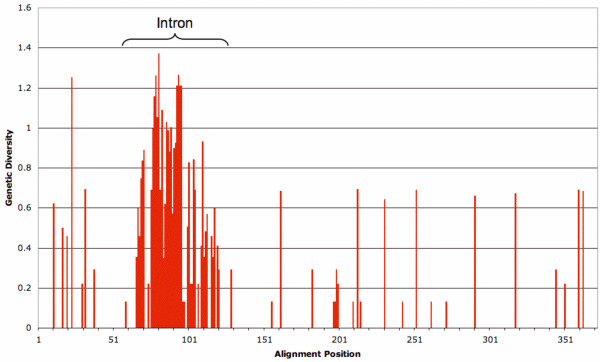
Genetic diversity. Shannon's alignment uncertainty or "entropy" [67] is plotted along an alignment of apomictic msp sequences illustrating the variability of the intron with respect to exons.